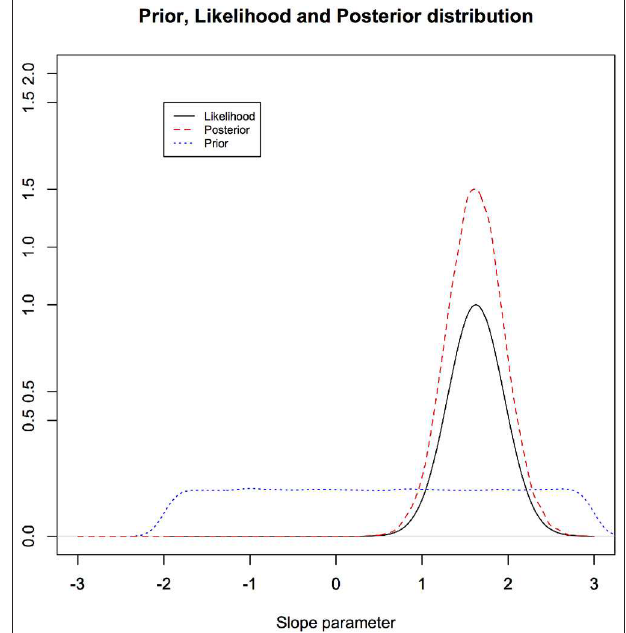
FIGURE 3 | Illustration of a prior distribution, likelihood function, and posterior distribution for the linear regression through origin: notice how much the data can change the prior beliefs. Highly informative data change the prior substantially and vice